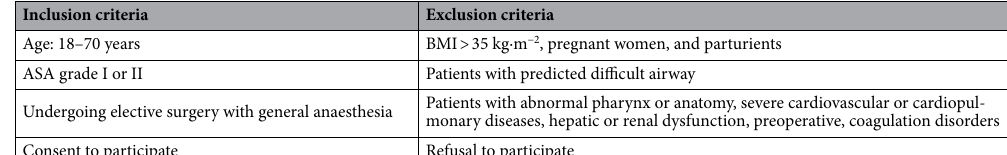
Table 1. Trial inclusion and exclusion criteria. BMI body mass index, ASA American Society of